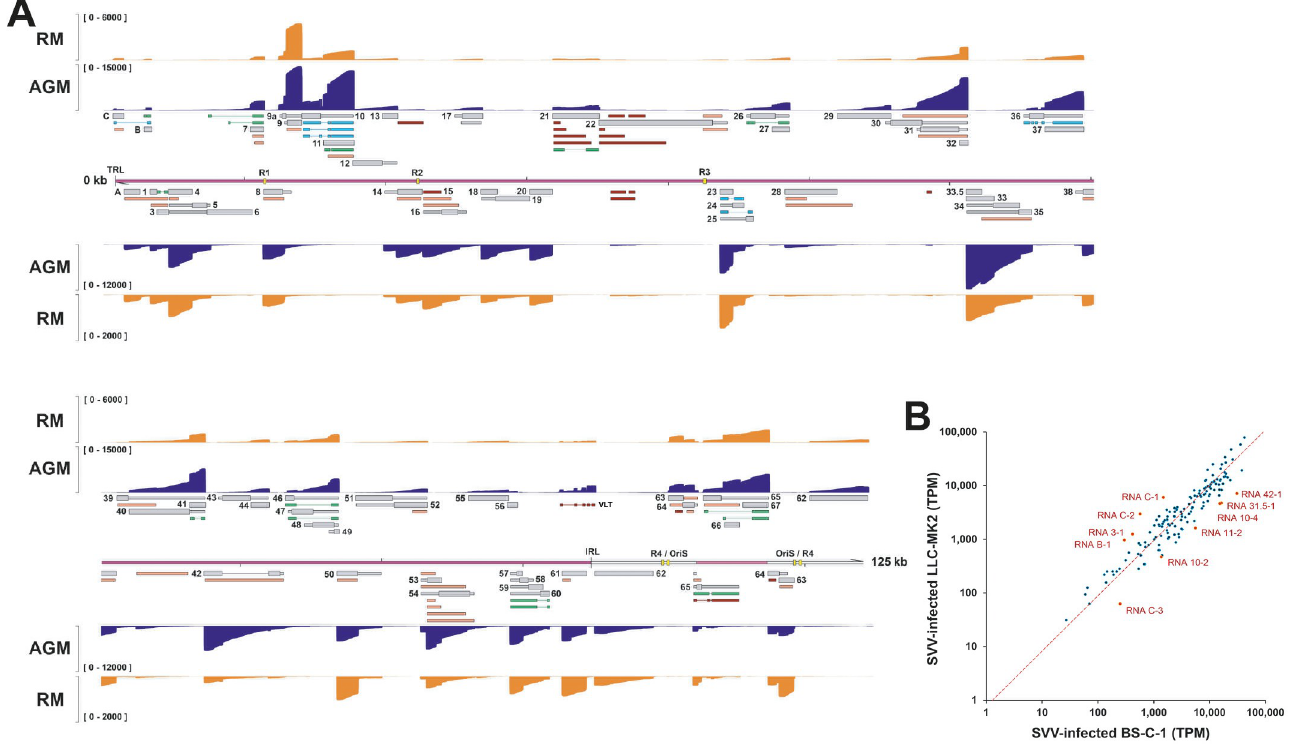
Fig 4. Comparison of the lytic SVV transcriptome in rhesus macaque (RM) derived LLC-MK2 cells and African green monkey (AGM) derived BS-C-1 cells. (A) Coverage plots showing dRNA-seq data of SVV-infected LLC-MK2 (orange) and BS-C-1 (dark blue) cells, with Y-axis indicating read depth per track. Canonical (grey), variant (orange), splice variant (green), fusion transcripts (blue) and non-coding (red) RNAs are indicated. Double black lines represent the SVV genome, with UL in purple fill, US in pink and IRS/TRS no fill, ticks indicate 10 kb intervals and the reiterative repeat regions R1 to R4 and both copies of OriS are indicated as yellow boxes on the genome track. (B) Scatter plot shows correlation between abundance (TPM) of SVV transcripts in LLC-MK2 cells (y- axis) and BS-C-1 cells (x-axis). RNAs differentially expressed (i.e. mean Log2 ratio (“TPM in BSC-1” / “TPM in LLC-MK2”) ± 2 times SD) between BS-C-1 cells and LLC-MK2 cells are highlighted and annotated in